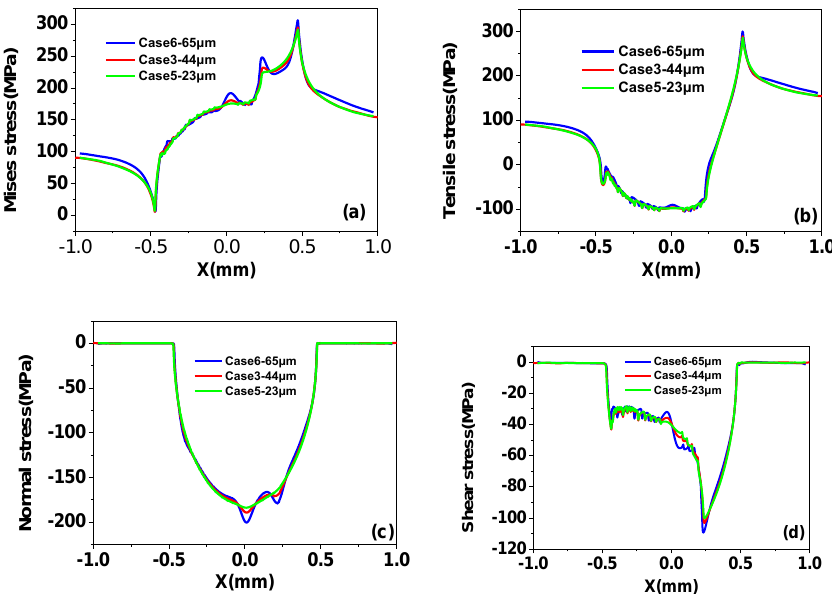
Figure 18. ( a ) Mises stress, ( b ) tensile stress, ( c ) normal stress, ( d ) shear stress distribution on the contact surface for different inclusion size